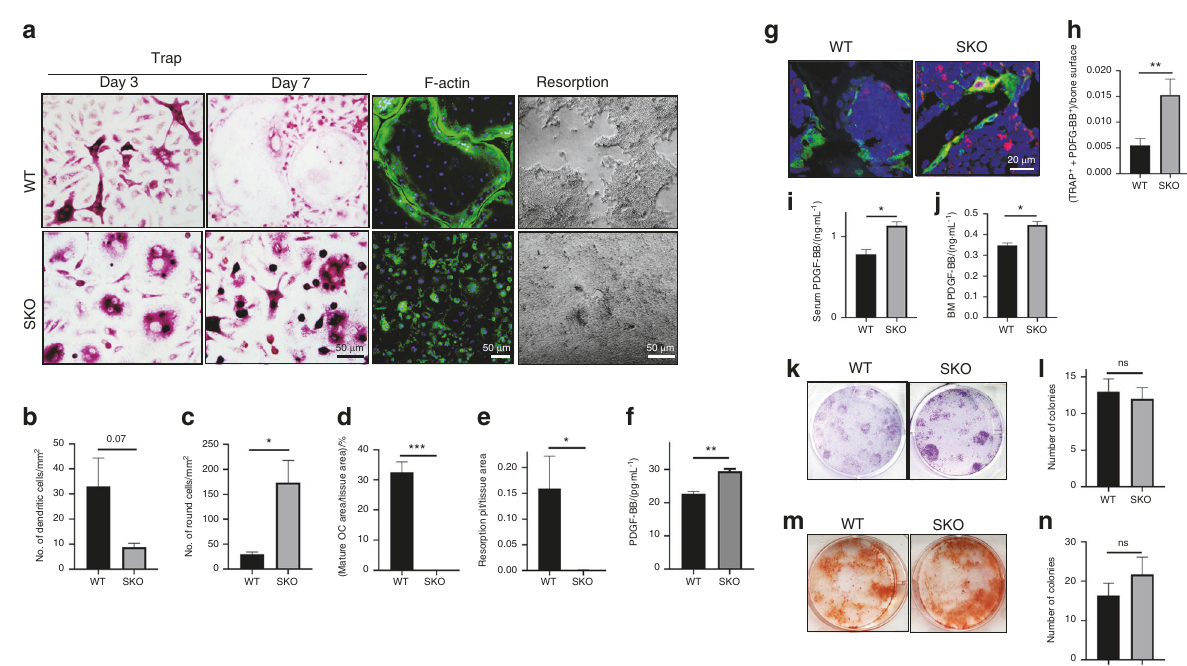
Fig. 3 Osteoclast maturation and bone resorption were impaired with excessive secretion of PDGF-BB in the SKO mice. a Representative images of TRAP staining ( fi rst and second columns), phalloidin staining (third column), and resorption pits (fourth column) of the osteoclast cultures that were induced from primary mouse bone marrow monocytes. TRAP staining was conducted on days 3 and 7 of osteoclastogenic induction. Phalloidin staining and resorption assays were conducted on day 7. b , c Quantitative analysis of TRAP staining on day 3 of osteoclastogenesis in a . d Quantitative analysis of TRAP staining on day 7 of osteoclastogenesis in a . * P < 0.05, *** P < 0.001. e The ratio of the resorption area in a . * P < 0.05. f ELISAs of the concentration of PDGF-BB in the conditioned media collected on day 7 of osteoclastogenesis. ** P < 0.01. g Coimmuno fl uorescence staining of TRAP (green) and PDGF-BB (red) in the trabecular bone of 3-month-old WT or SKO mice. h Quantitative analysis of the number of TRAP + PDGF-BB + cells in g . n = 5, ** P < 0.01. ELISAs of the concentration of PDGF-BB in the serum ( i ) and bone marrow ( j ) of the 3-month-old WT or SKO mice. * P < 0.05. k , l Crystal violet staining and quantitative analysis of bone marrow stromal cells cultured for 10 days. m , n Alizarin red staining of bone marrow stromal cells cultured in osteogenic medium for 21 days. Bone marrow stromal cells were collected from the bone marrow of the 3-month-old WT or SKO mice. ns: not signi fi